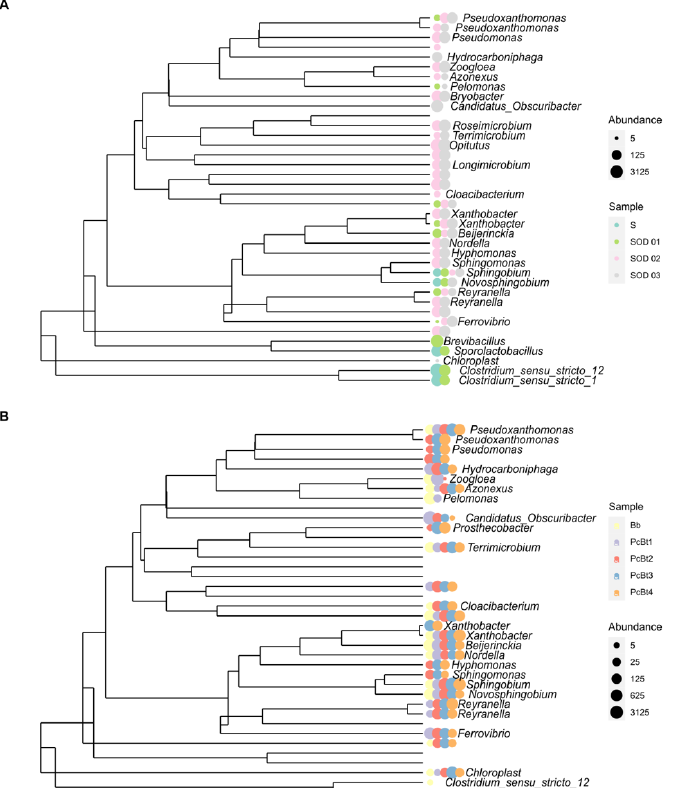
Figure 4. Evolution of the main identified genus along the adaptation process. ( A ) S: Bare Soil without treatment. S OD : Rhizospheric soil after application of microbial solution, where numbers mean bacterial OD concentration. ( B ) Bb: Batch reactor (complete mix, glucose to citrate finding, and N 2 by air supply) after ten days. PcB: Packed Bioreactors (citrate as the only carbon source and N 2 by air supply) (PcB t1 = 112, PcB t2 = 160, PcB t3 = 200, and PcB t4 = 240 days). The size of the circles represents rRNA-16s abundance.